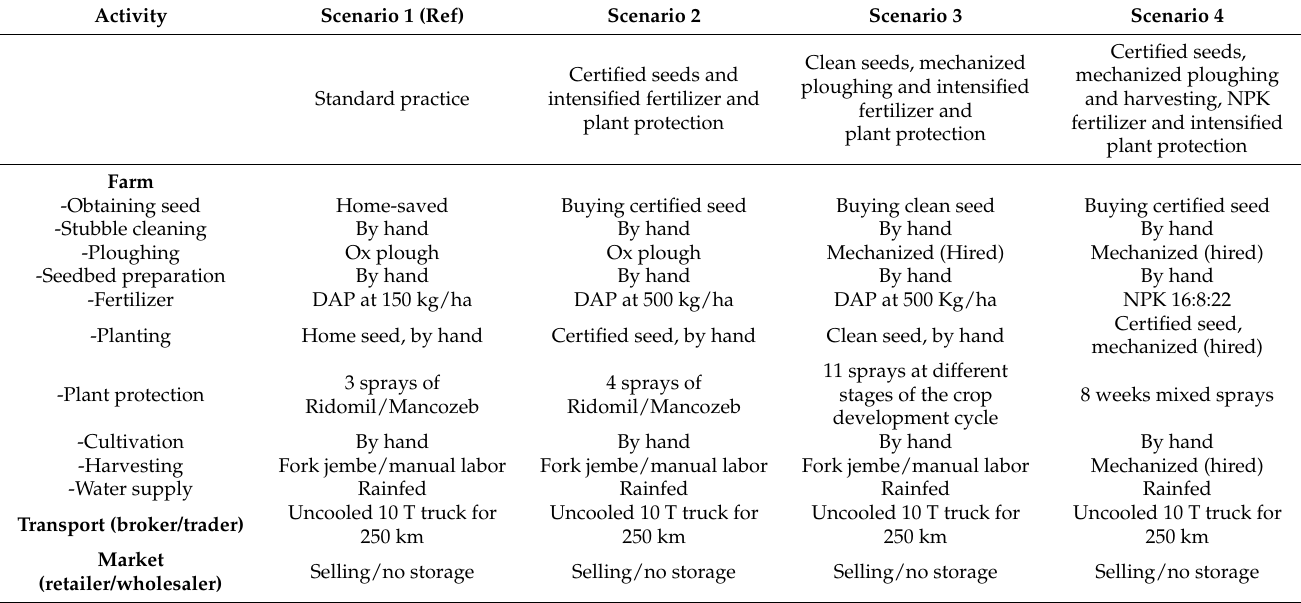
Table 3. Activities per